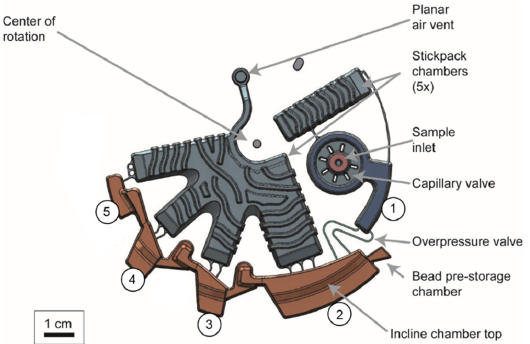
Figure 6. Design of the nucleic acid extraction microfluidic module. #1: Lysis chamber. #2: Binding chamber. #3: Washing chamber 1. #4: Washing chamber 2. #5: Elution chamber. Stiffening structures